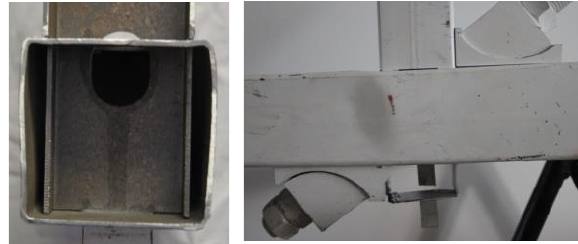
Figure 6: Chord webs failure under